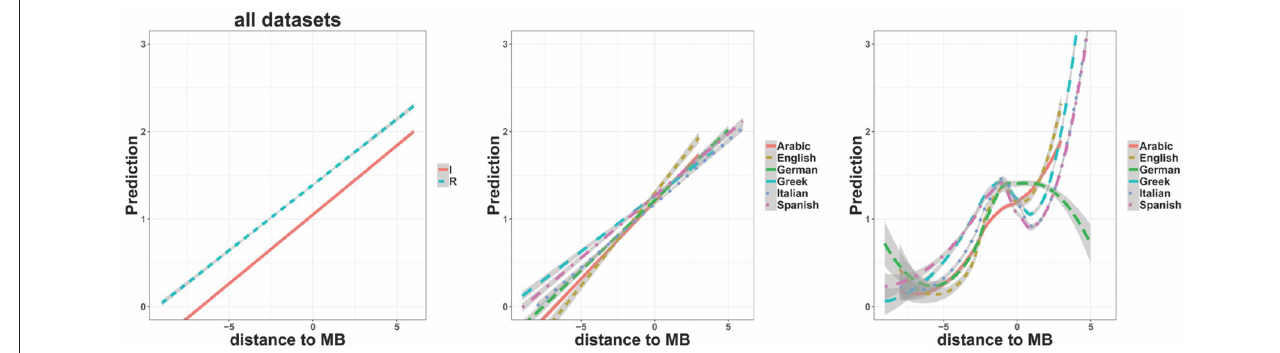
FIGURE 4 | Regression plots of TSOM prediction rates in word recoding by letter position to the word stem-suffix boundary ( distance to MB =0): (possibly prefixed) stems are associated with x -values < 0, and endings with x -values ≥ 0. (Left panel) linear interaction with the categorical regular (cyan) vs. irregular (red) classification of verb paradigms in all languages. (Center panel) linear interaction with sample languages as categorical fixed effects. (Right panel) non-linear interaction with sample languages as categorical fixed effects. All plots are obtained by using the R ggplot2 package; related models are respectively calculated with lm function and gam function ( gamm4 package). Shaded areas indicate 95% confidence intervals.